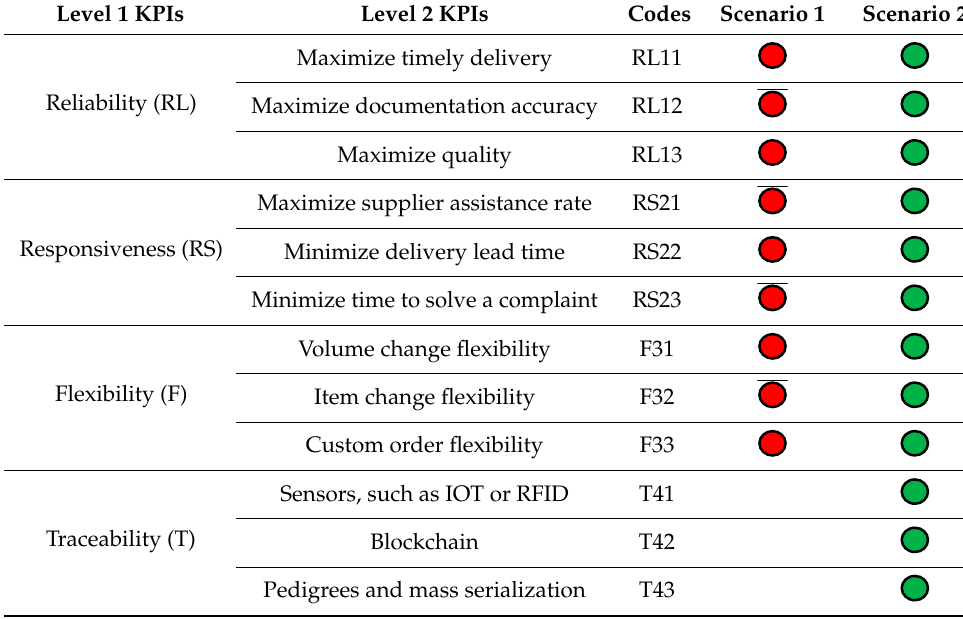
Table 2. List of the KPIs and identification codes. Table 2 contains the level 1 KPIs (main criteria) and level 2 KPIs (sub-criteria) for both scenarios and their generated codes for this study, which can be distinguished by the same colors represented in Figure 4.